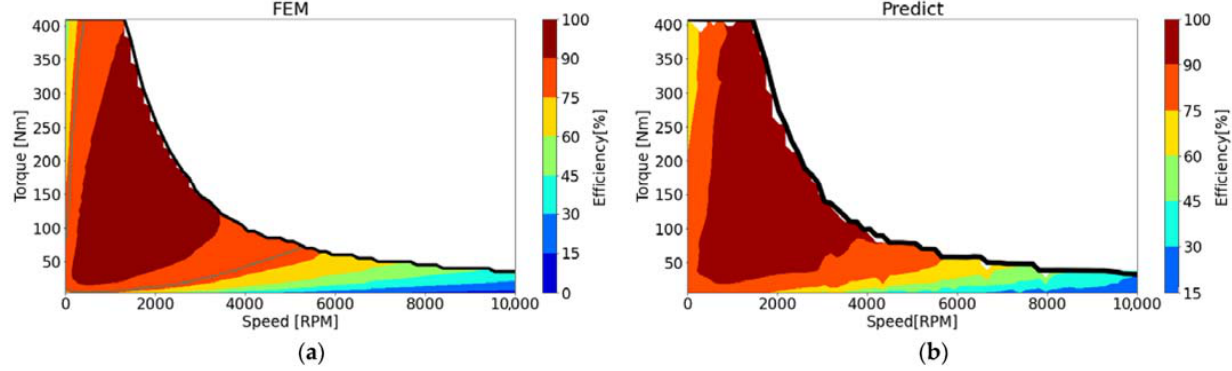
Figure 9. Analyzed motor core loss: ( a ) 2D FEM; ( b ) proposed method.